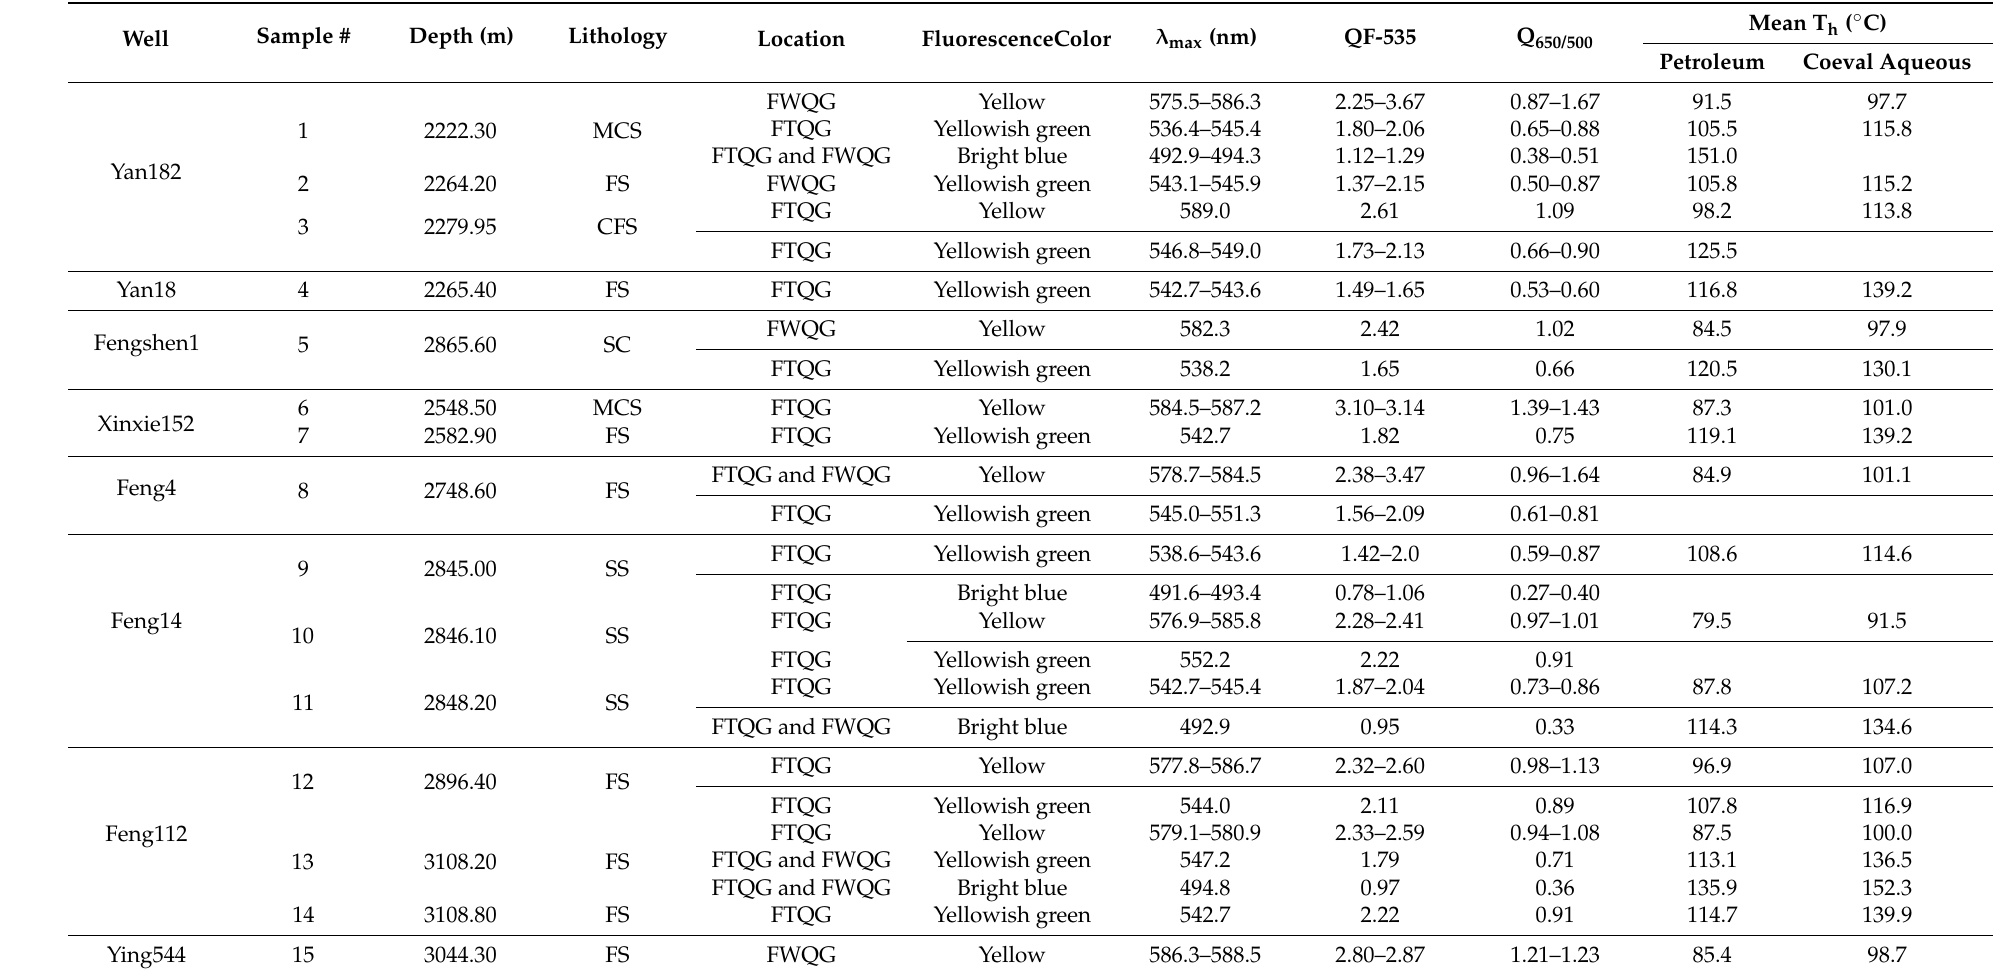
Table 1. Sample information, occurrence and fluorescence property of typical petroleum